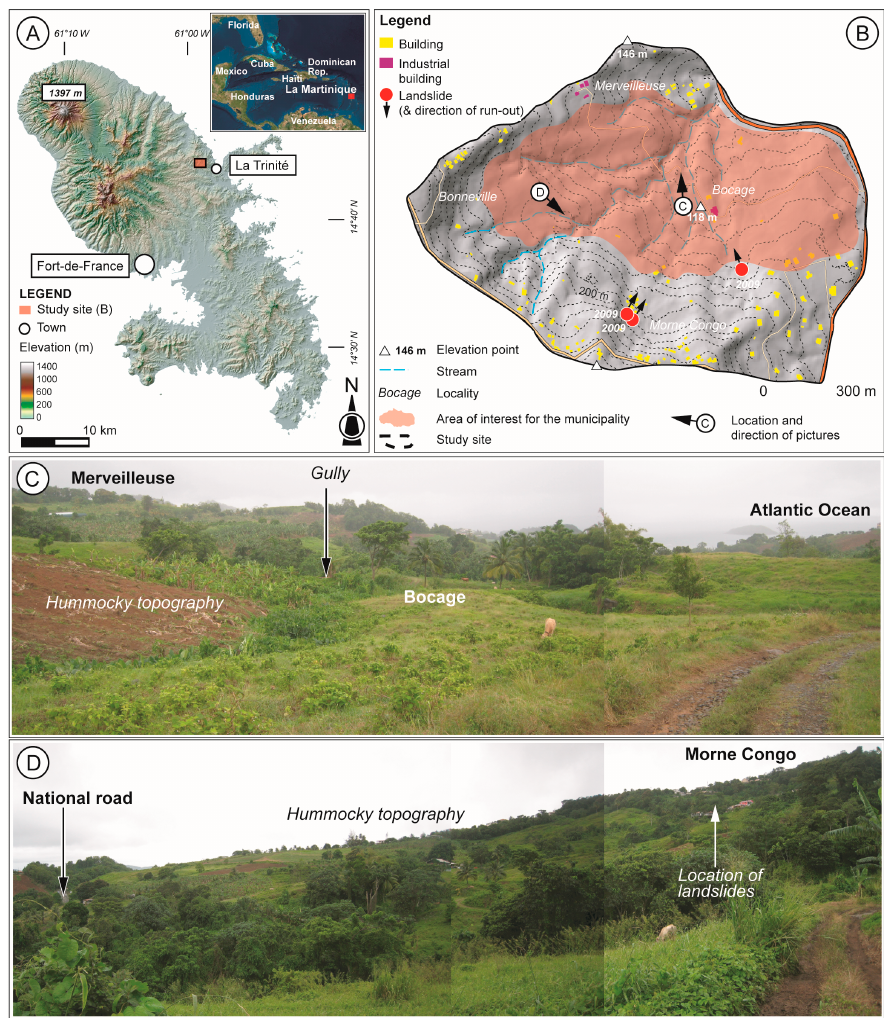
Figure 1. Location of the test site (coordinates are expressed in Lat/Long; projection WGS84 UTM 20N—EPSG 32620). ( A ) Location of Martinique and test site; ( B ) study area; ( C ) view of Merveilleuse from the track; ( D ) view of Morne Congo from Bonneville.